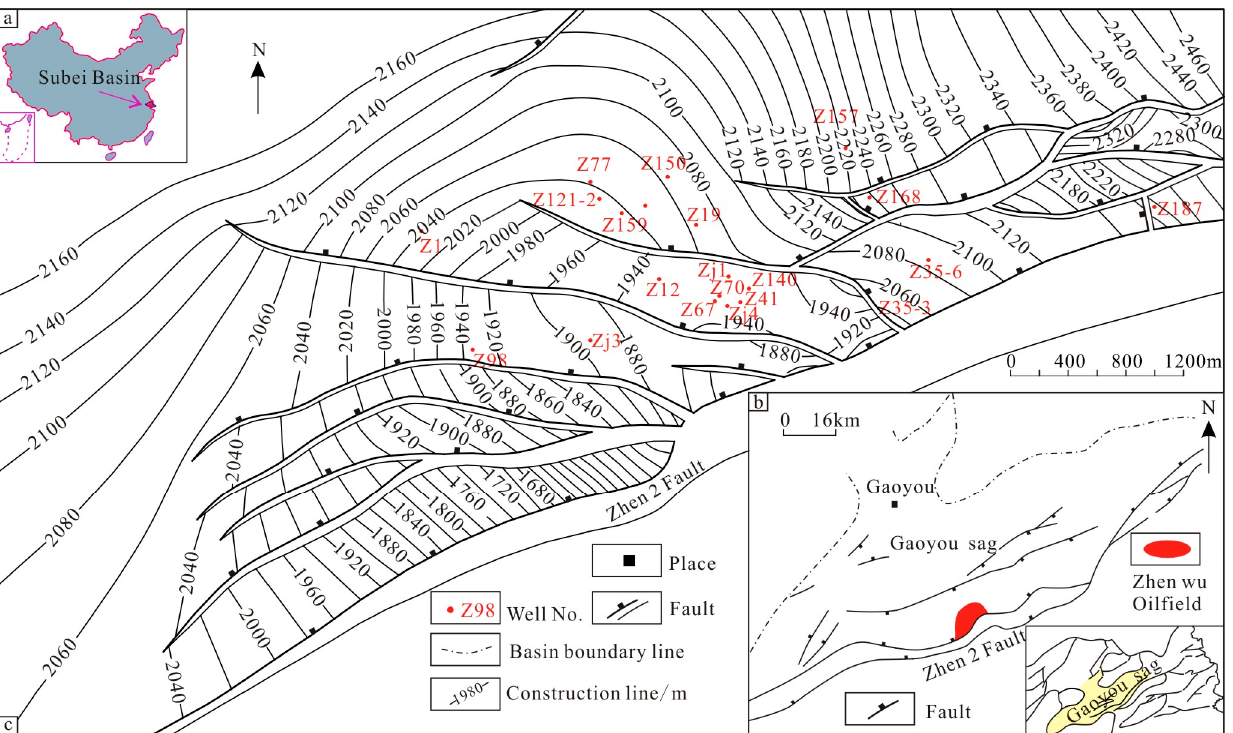
Figure 1. Tectonic underside structure and coring well distribution position of E 2 s 14–7 in the Zhenwu area, Gaoyou Sag. ( a ) Location of the Subei Basin in the east of China; ( b ) location of Gaoyou Sag; ( c ) sketch of Zhenwu Oilfield.